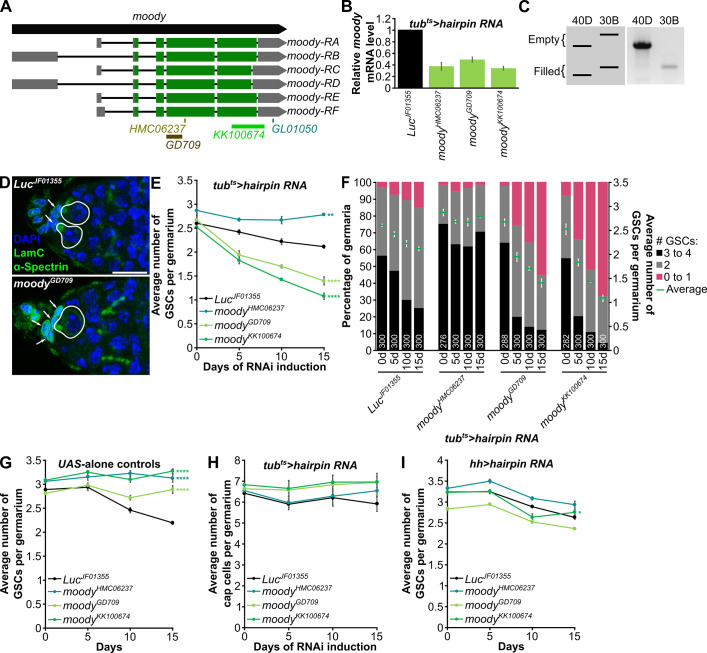
moody appears to function in somatic cells to regulate GSC maintenance.(A) Schematic showing moody gene and its six mRNA isoforms. The hairpin lines UAS-moodyHMC06237 and UAS-moodyGD709 target distinct portions of the protein coding regions shared by all transcripts, UAS-moodyKK100674 targets part of the protein coding region and part of the 3’ UTR, and UAS-moodyGL01050 (optimized for germline expression) targets a portion of the 3’ UTR sequences shared by all transcripts. (B) RT-qPCR analysis of moody from ovariectomized females at seven days of ubiquitous somatic moody or Luc control RNAi. Three biological replicates were analyzed, with 10 females per replicate. (C) Left: Schematic of expected PCR band sizes for KK lines. Right: PCR gel showing that moodyKK100674 is inserted in the non-annotated 30B site, and not in the annotated 40D site. (D) Germaria from females at five days of ubiquitous somatic knockdown of Luc control or moody (using moodyGD709). DAPI (blue) labels nuclei. LamC (green), nuclear lamina of cap cells; α-Spectrin (green), fusome. Cap cells, arrows; GSCs, solid outlines. Scale bar, 10 μm. (E) Line graph showing the average number of GSCs per germarium at zero, five, 10, and 15 days of ubiquitous somatic knockdown of moody or control Luc. (F) Bar graph showing the percentage of germaria with zero to one, two, or more than three GSCs on the left y-axis and the average number of GSCs per germaria on the right y-axis at zero, five, 10, and 15 days of ubiquitous somatic knockdown of moody or control Luc. Same data are shown in (E and F). (G) Line graph showing the average number of GSCs per germarium at zero, five, 10, and 15 days after eclosion for UAS-alone controls of moody or Luc hairpin RNA lines. (H) Line graph showing the average number of cap cells per germarium at zero, five, 10, and 15 days of ubiquitous somatic knockdown of moody or control Luc. (I) Line graph showing the average number of GSCs per germarium at zero, five, 10, and 15 days of hh-Gal4-driven knockdown of moody or control Luc. For (E-I), three biological replicates were analyzed for each genotype. The total number of germaria per genotype per timepoint for (E,F,H) are indicated in (F). For (G,I), a total of 300 germaria were analyzed per genotype per timepoint. *p<0.05; **p<0.01; ****p<0.0001, ANOVA: two-factor with replication. Data shown as mean±s.e.m.